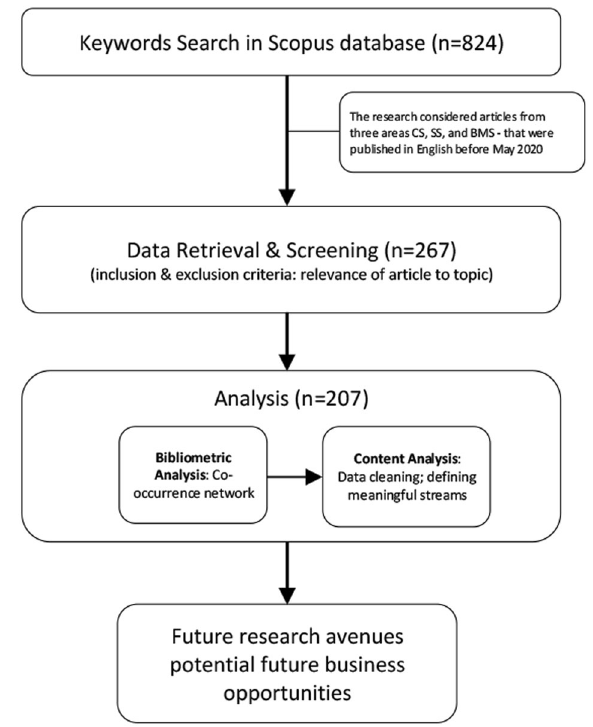
Fig. 2 Methodological approach. Overview of the methodological research approach of this